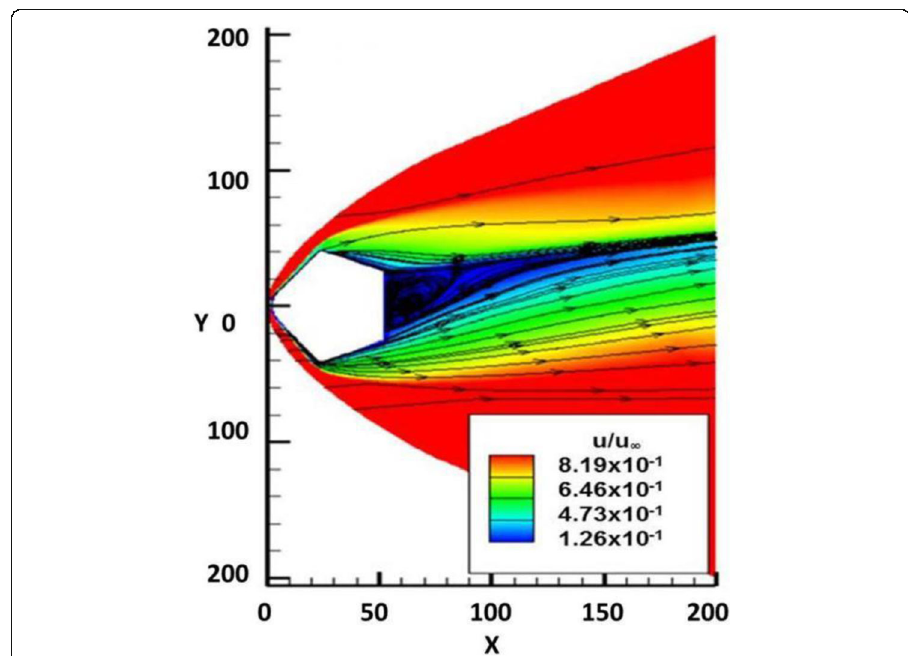
Fig. 12 Velocity traces of Stardust probe at reentry speed of 11.37